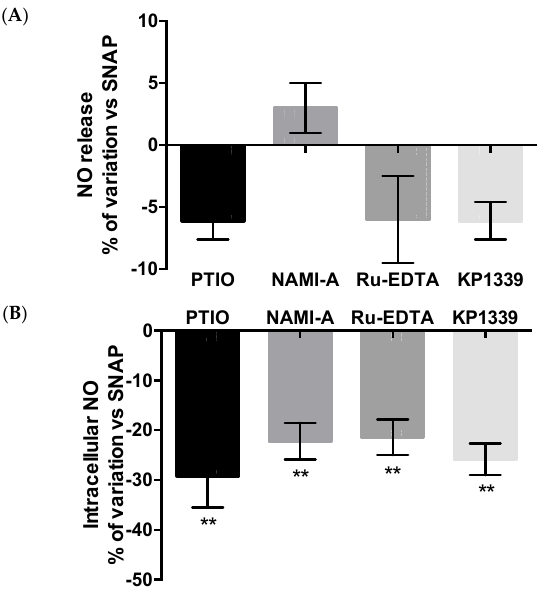
Figure 9. Effects of the pre-treatment with NAMI-A, Ru-EDTA, KP1339, and PTIO on SNAP induced NO production/release by EA.hy926 cells. EA.hy926 cells were pre-treated with 10 − 4 M NAMI-A, Ru-EDTA, KP1339, and PTIO for 2 h, then, after washing, with an equimolar concentration of SNAP for further 2 h. NO was measured in the extracellular medium by Griess test ( A ) or at intracellular level by the fluorescent dye DAF-2 DA; ( B ) Data are expressed as per cent of variation vs. SNAP treated cells and are the mean ± S.E.M. of five samples per group. ANOVA and Tukey–Kramer: ** p < 0.01 vs. Control.